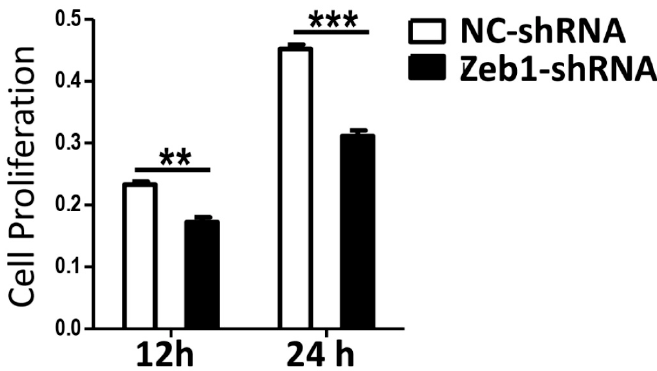
Figure A1. Knock-down of Zeb1 inhibits mK3 cell proliferation. mK3 cells were 48 h post-treated with vectors of target shRNA or the respective control vector, then the equal 2000 cells were seeded into the 96-well. Proliferating mK3 cells were tested in living cells using MTT at 12 and 24 h. The formazan product was detected by the intensity of absorbance at 590 nm wavelength to indicate cell vitality. The absorbance intensity of Zeb1 knocked down cells was smaller than the negative control cells at both 12 and 24 h. The absorbance present were examined by a microplate reader and results were displayed as mean ± SD ( n = 3). ** p < 0.01, *** p < 0.001 negative control vectors.